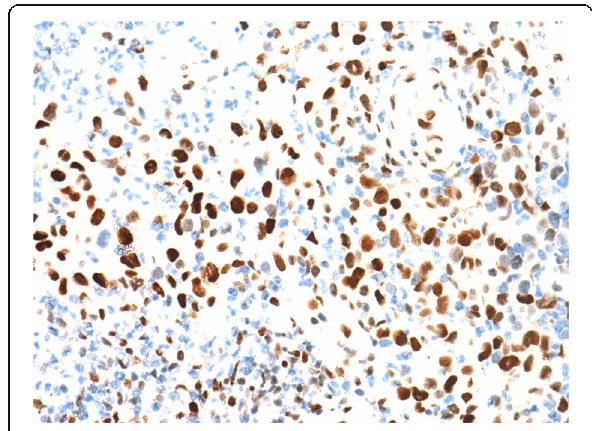
Fig. 4 Immunohistochemical expression of p53 protein in the nuclei of neoplastic cells